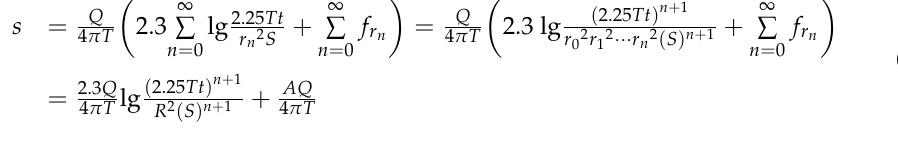
that the drawdown ( s ) versus logarithmic time (lg t) curve is linear, as shown in Figure 3. The slope of the straight line ( i ) is given by